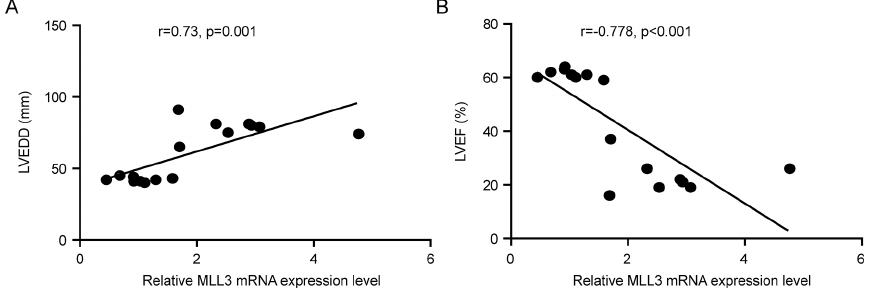
Figure 4. MLL3 expression level closely correlates with severity of DCM. Correlation analysis of MLL3 expression level with (A) left ventricular end-diastolic dimension or (B) left ventric- ular ejection fraction; r indicates correlation